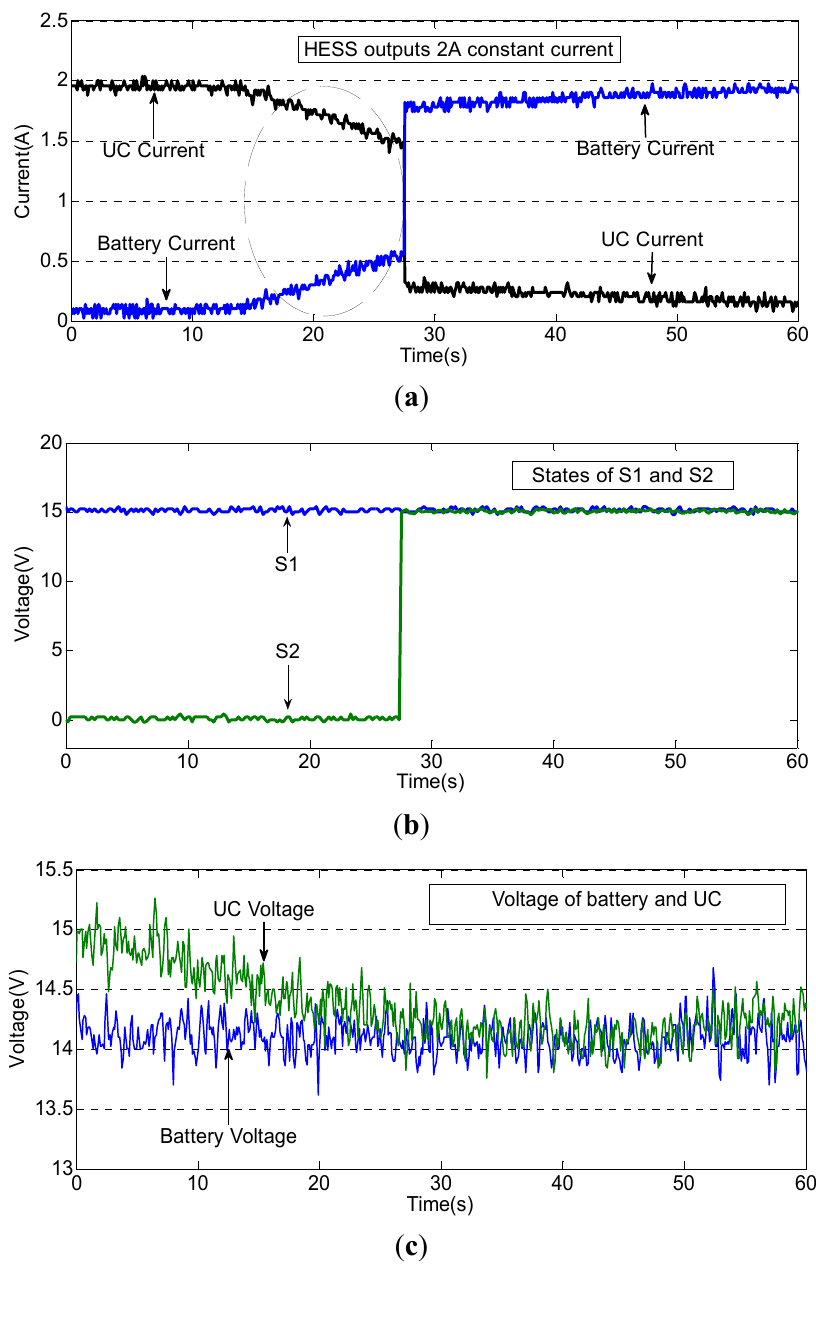
Figure 17. HESS producing a constant 2 A current, initially in Mode I: ( a ) currents from the battery bank and the UC bank; ( b ) states of S1 and S2; ( c ) voltage of the battery bank and UC